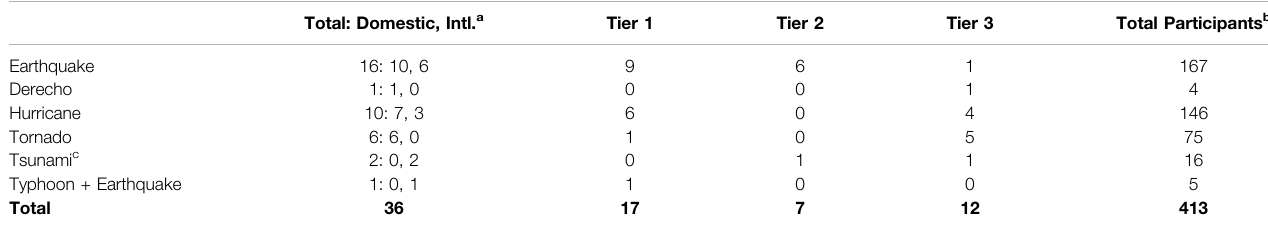
TABLE 6 | Summary of StEER event responses (Sept. 2018-Dec.2020). Total: Domestic, Intl.